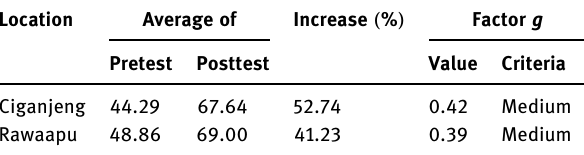
Table 8: Pretest and posttest results of farmer researchers Location Average of